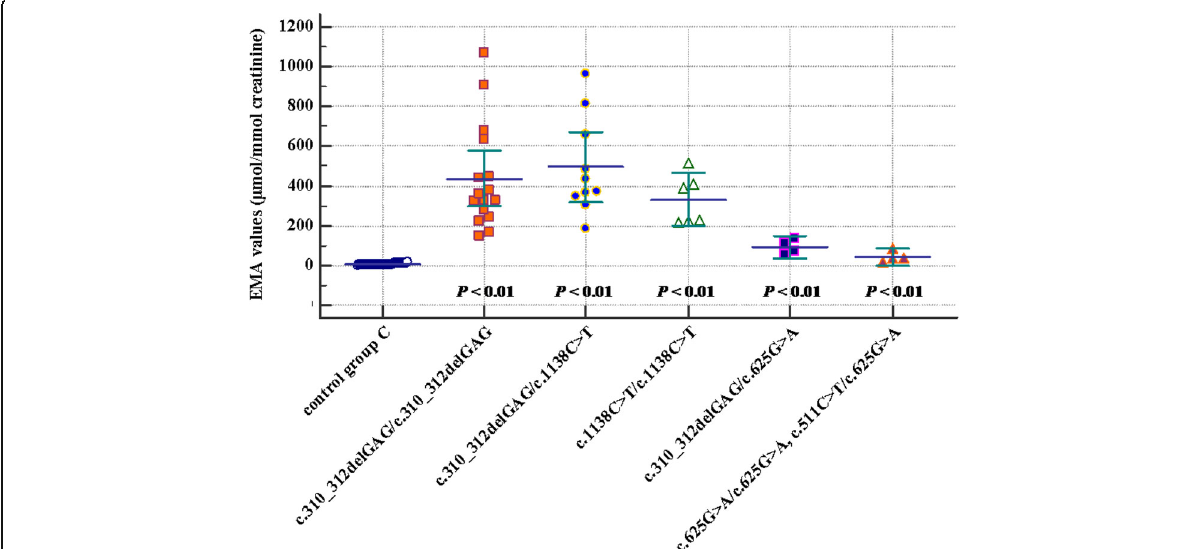
Fig. 3 A multiple variables graph (MedCalc® v15.11.4) showing EMA values ( μ mol/mmol creatinine) in control group C compared with EMA values sorted according to SCADD genotype and statistical significance related to the control group